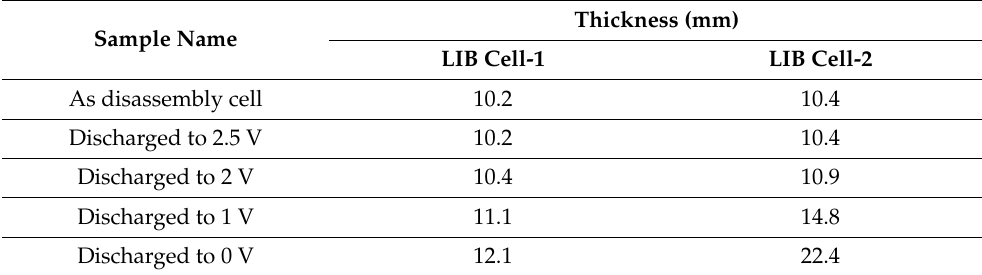
Table 2. Thicknesses of LIB cell-1 and LIB cell-2 when discharged to various cut-off potentials.